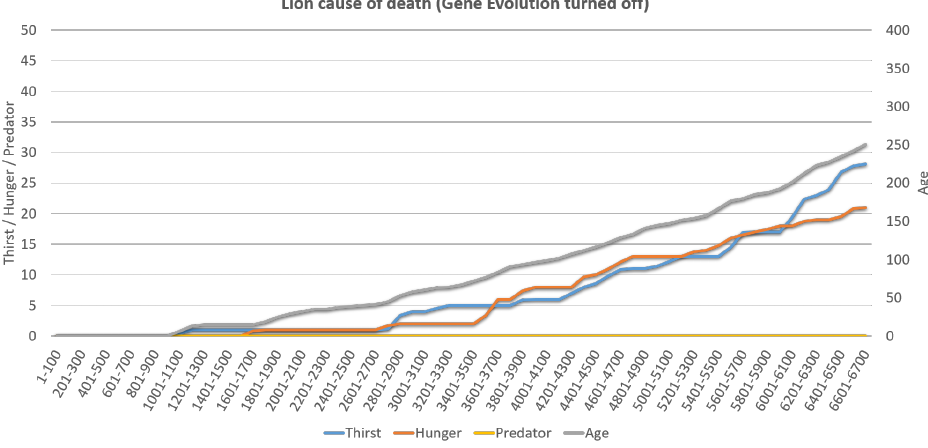
Figure 22. The diagram shows the cause of deaths for the Lion population without